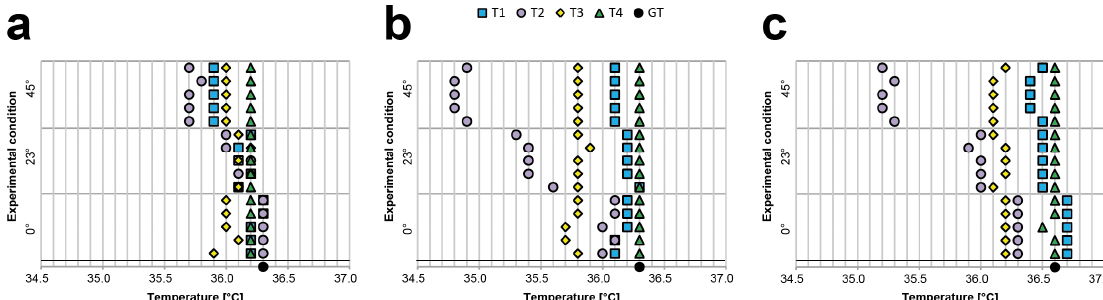
Figure 5. Visual representation the temperature data (reported in the x -axis in °C) collected during the body–device angle experiment. We kept the TECNIMED VisioFocus PRO 06480 at 7 cm, the Medek MDI261 at 3 cm and the other two thermometers at 5 cm, and we acquired five measurements for each device at three different angles: 0 degrees (i.e., thermometer perpendicular to the forehead), 23 degrees, and 45 degrees; ( a ) Subject 1 , ( b ) Subject 2 , and ( c ) Subject 3 values.